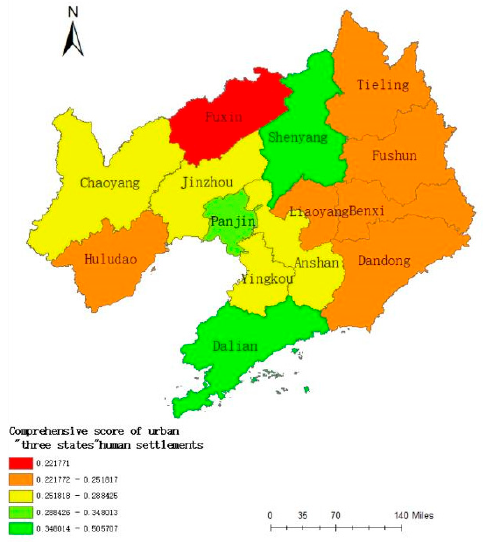
Figure 3. Comprehensive score of urban “three states” human settlements.